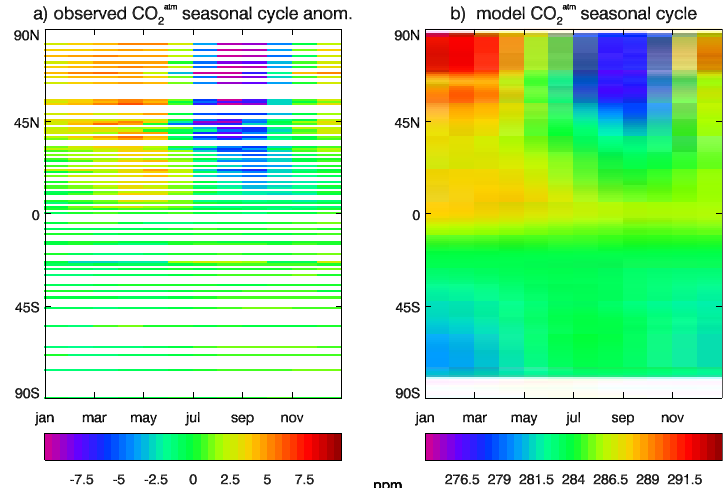
Fig. 1. (a) Observed atmospheric CO 2 seasonal cycle at latitudes with CarbonTracker flask measurement sites containing at least five years worth of data (Peters et al., 2007). Seasonal cycle calculated from detrended monthly values and presented as an anomaly from the annual mean at that latitude. (b) Pre-Industrial latitudinally averaged surface atmospheric CO 2 seasonal cycle simulated in the HadGEM2-ES model when run with interactive carbon cycle components. For consistency with calculations presented in this study, only CO 2 concentrations above the ocean have been considered. Note that although the relative magnitude of changed described by the color scale is identical in both panels, the left panel shows anomalies from zero, and the right, absolute values. This has been done to allow comparison between pre-industrial and detrended present-day values. The left panel shows the observed seasonal cycle at each latitude as an anomaly from its annual mean of zero, whereas annually averaged values for any given latitude in the right panel are not necessarily